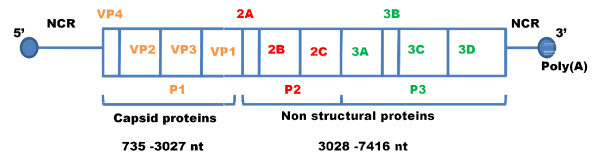
Genomic structure of hepatitis A virus. HAV genome is divided into a 5' non-coding region (5'NCR), a giant open reading frame, and a non-coding region (3'NCR). The coding region is subdivided into regions P1, P2 and P3. Adapted from: Totsuka and Moritsugu; Intervirology 1999; 42: 63.